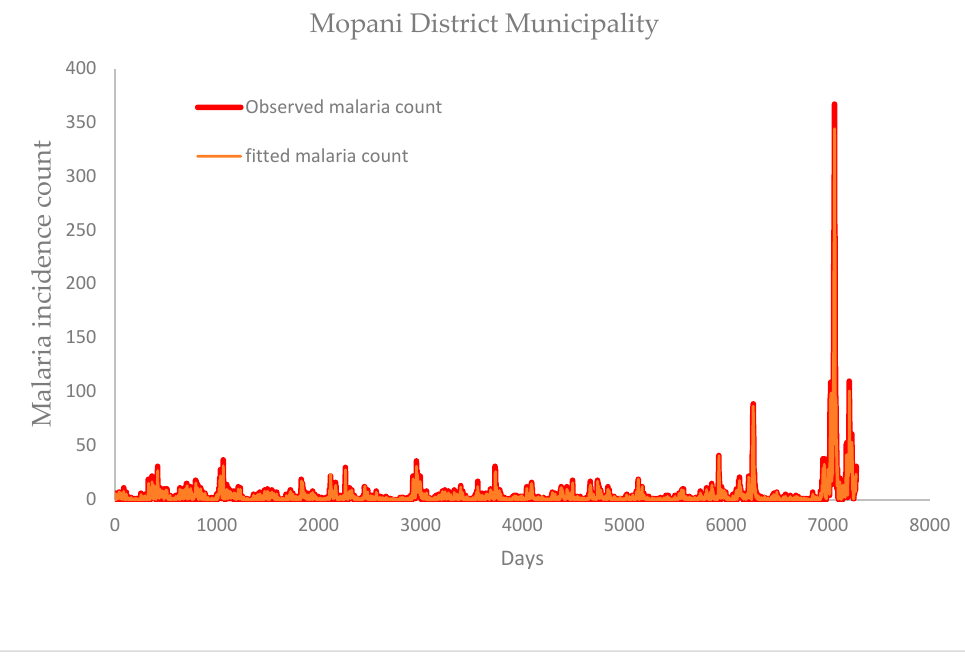
Figure 7. Comparison between fitted and observed malaria count for Mopani District.